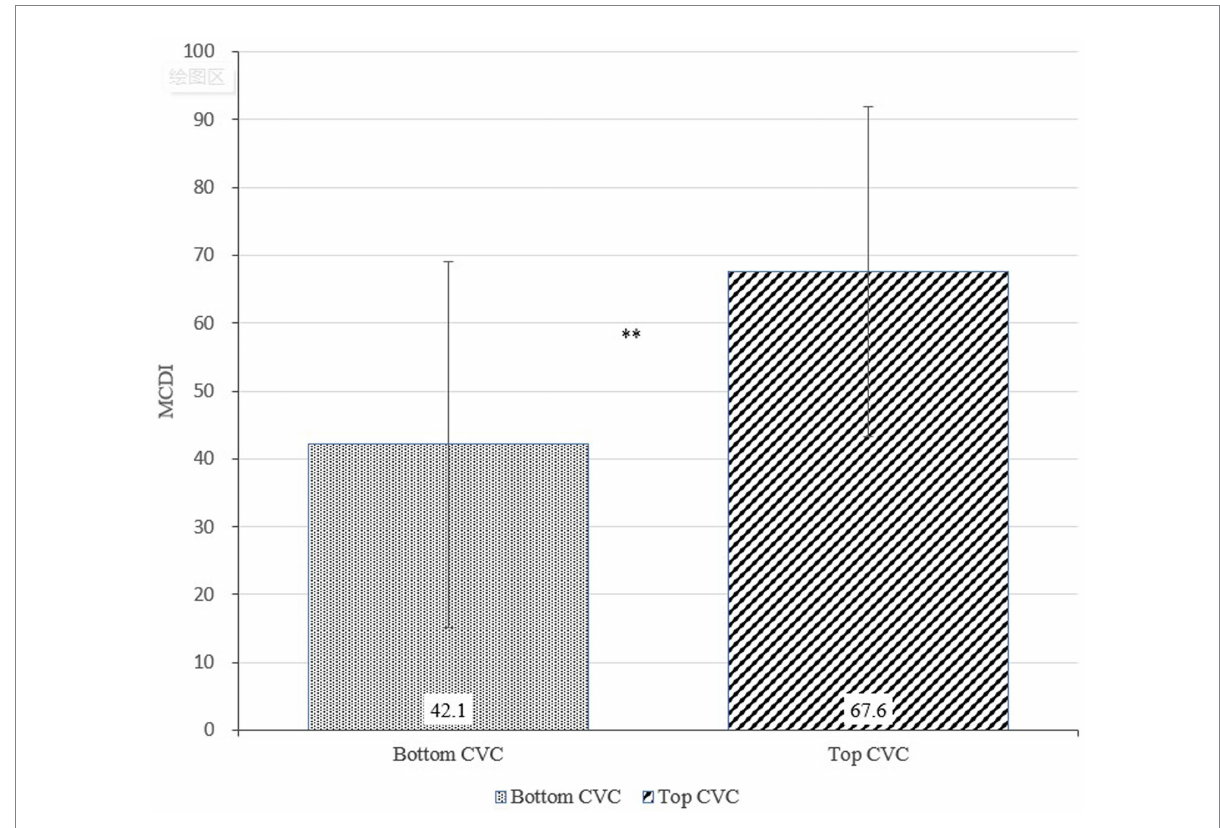
FIGURE 8 Differences in MacArthur-Bates Communicative Development Inventories (MCDI) scores between top and bottom terciles of Child Vocalization Count (CVC; p -value =